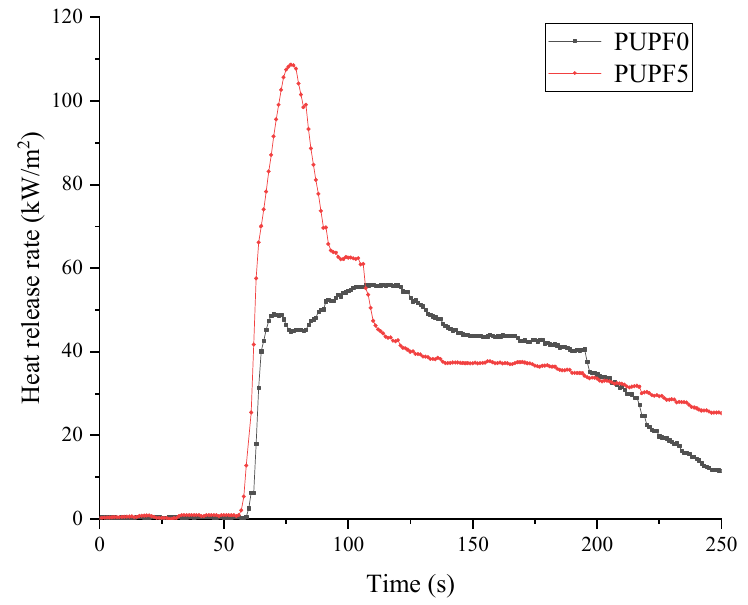
Figure 11. Heat release rate curves for PUPF0 and PUPF5. Table 5. Cone calorimetric data for PUPF0 and PUPF5 at a heat flux of 50 kW/ m 2 . Sample